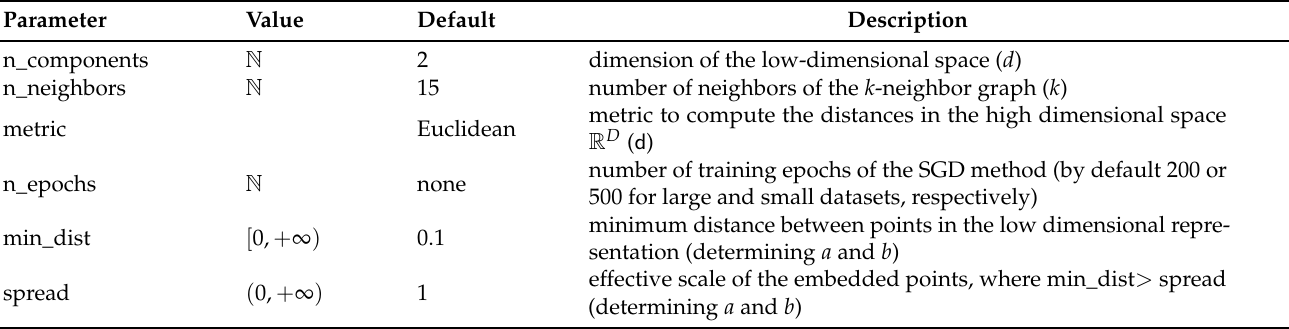
Table 4. Description of the key hyperparameters of the UMAP